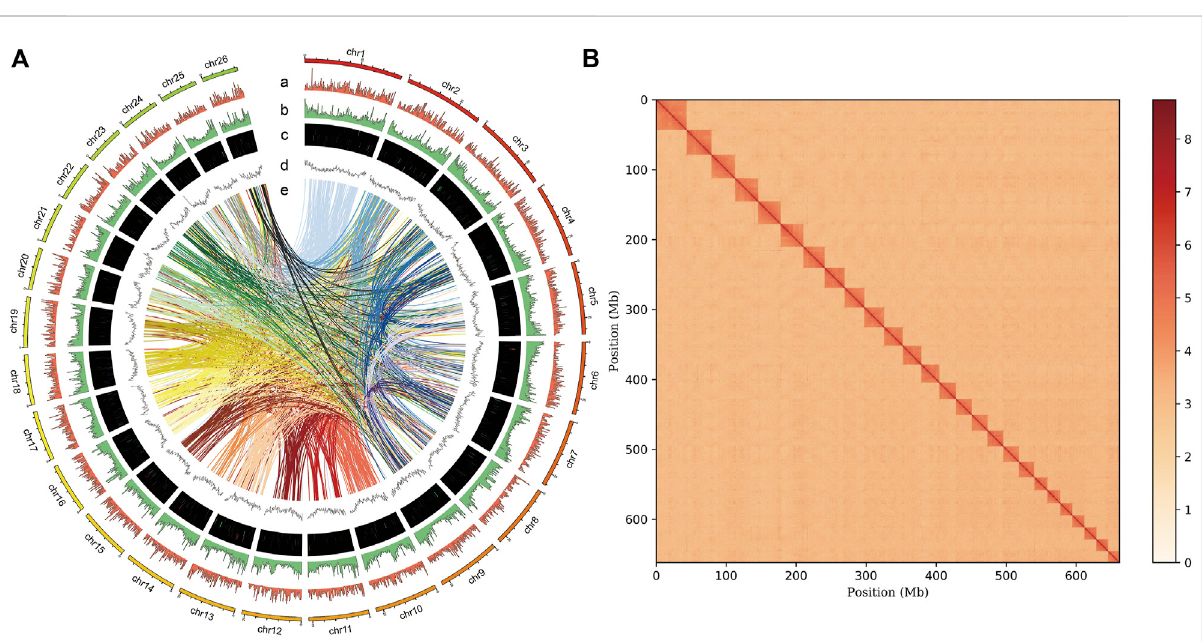
FIGURE 1 Genome assembly of P. vachelli . (A) Characteristics of 26 chromosomes of P. vachelli . Tracks from the outside to the inside represent distribution of gene density (a), repetitive sequence density (b), distribution of non-codling RNAs (ncRNAs) (c), GC content (d) and gene collinearity (e).Band widthisproportional tothesyntenic blocksize. (B) Interaction between chromosomes ofthe P.vachelli scaffolds.Theblocksrepresentthe contacts between one location and another. The color re fl ects the intensity of each contact, with deeper colors representing higher